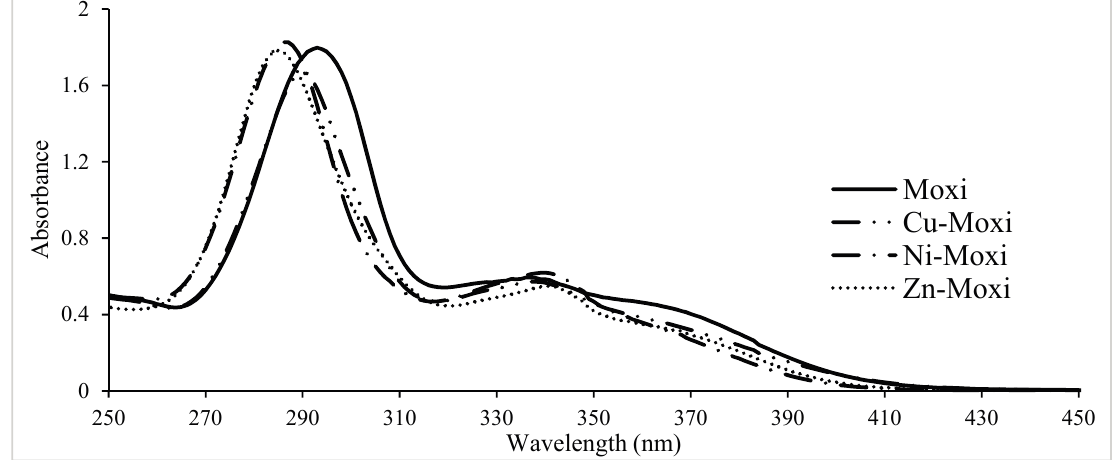
Figure 2. UV-Vis spectra of Cu 2+ -moxifloxacin solutions against free moxifloxacin as a